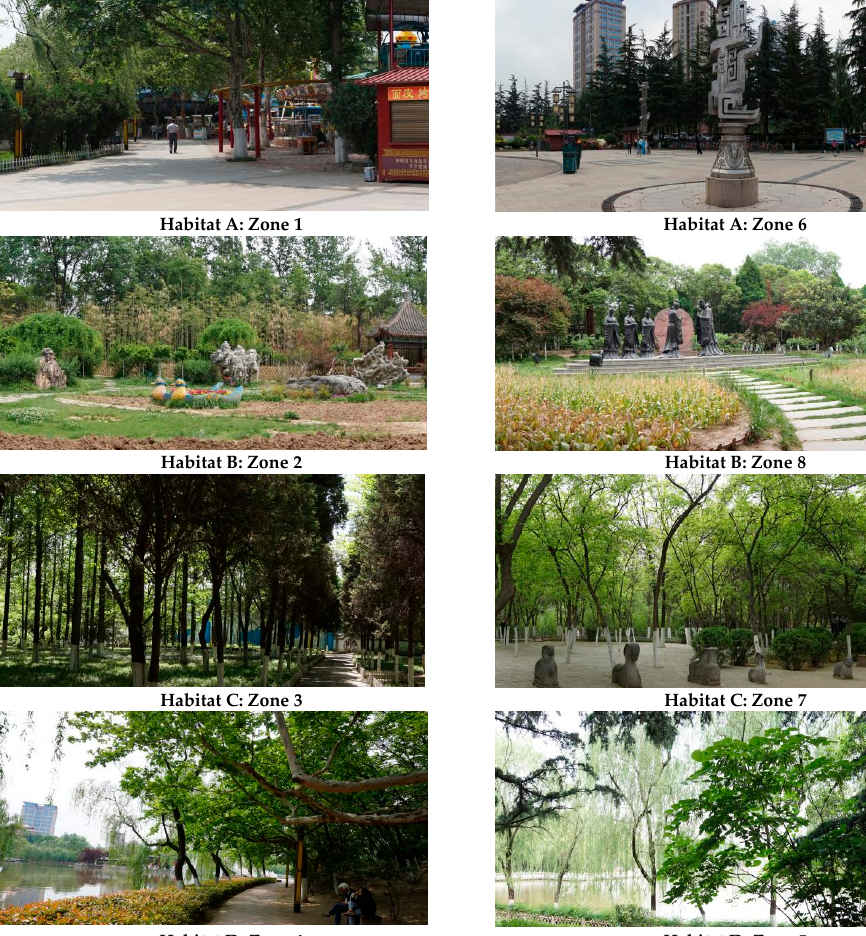
Figure 3. Typical landscape unit types and included regions. Habitat (A) grey space dominated by rigid pavement with conifer or broad-leaved evergreen trees around or at the upper boundaries; Habitat (B) open landscape; Habitat (C) single layer forest space; Habitat (D) Multi-layer vegetation space near the water